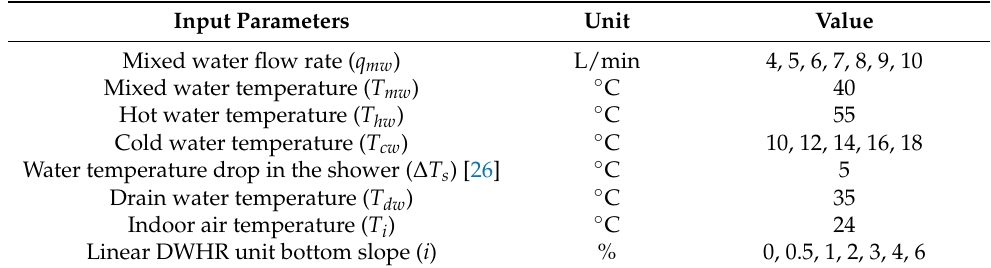
Table 1. Assumed values of the input parameters for the efficiency analysis of shower heat exchangers. Input Parameters Unit